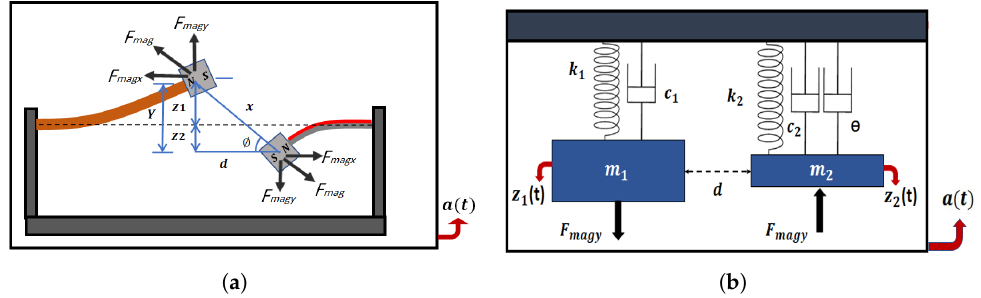
Figure 2. ( a ) Magnetic interactions between LFB and HFB. ( b ) Two-degrees-of-freedom spring-mass- damper systems for the LFB and